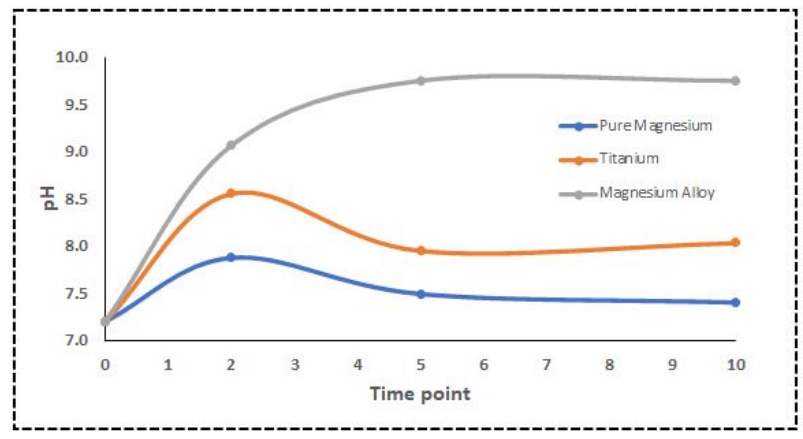
Figure 6. Changes in pH of DMEM solutions containing different disks.